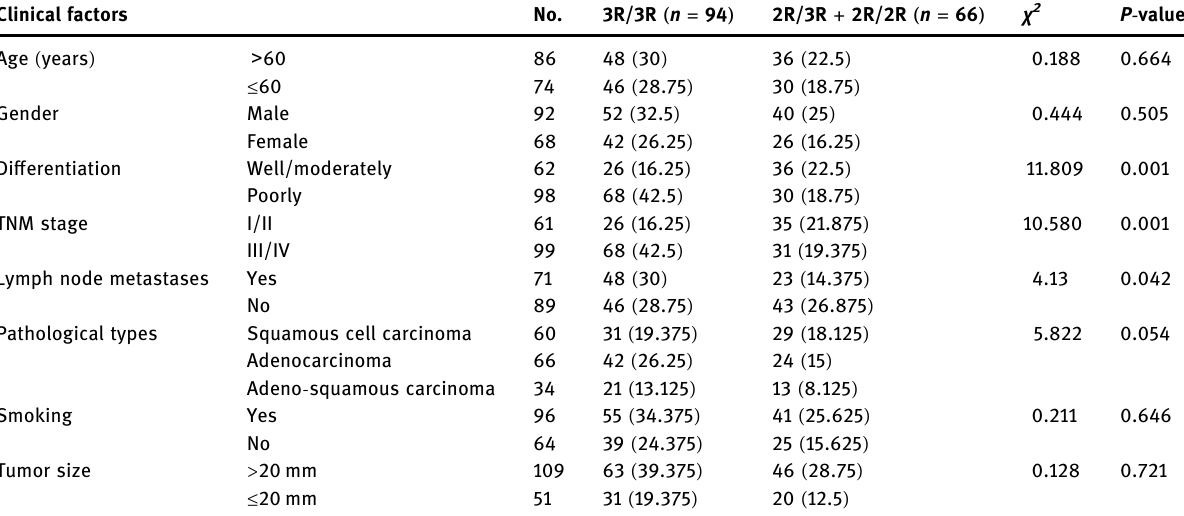
Table 4: The relationship between TS - 5 ′ UTR polymorphism and clinicopathological factors Clinical